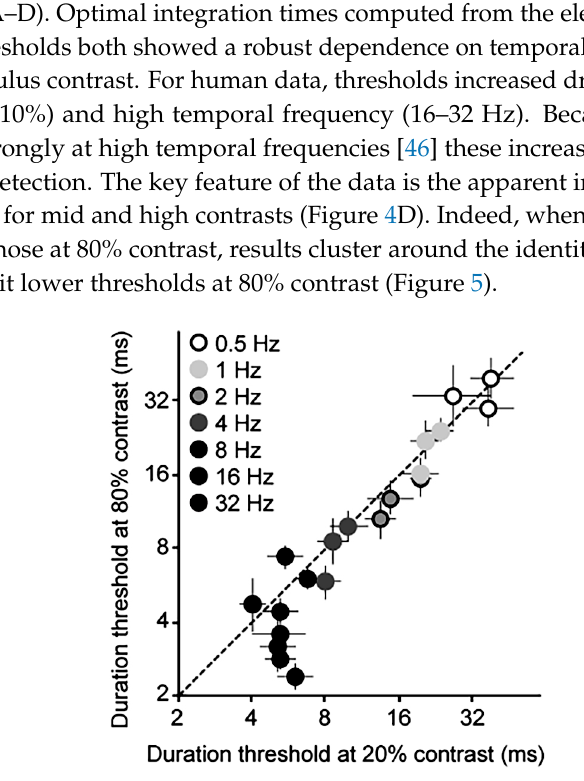
Figure 5. Effects of contrast on duration thresholds. Thresholds at 20% contrast are plotted against those at 80% contrast for a range of temporal frequencies. Data are shown for individual subjects, with error bars showing 95% confidence